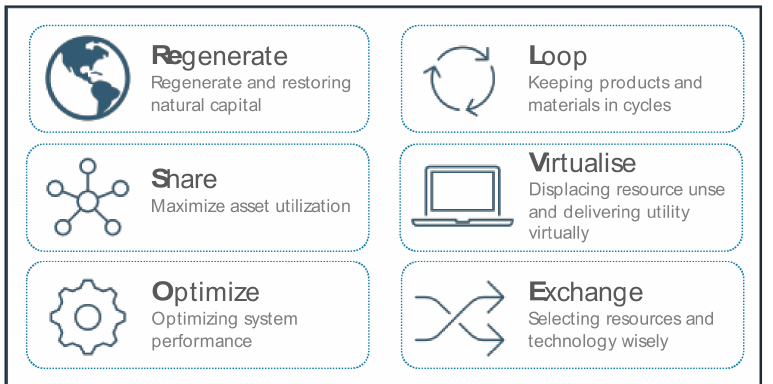
Figure 1. The Regenerate, Share, Optimize, Loop, Virtualize, Exchange (ReSOLVE) framework. Adapted from [26,28].